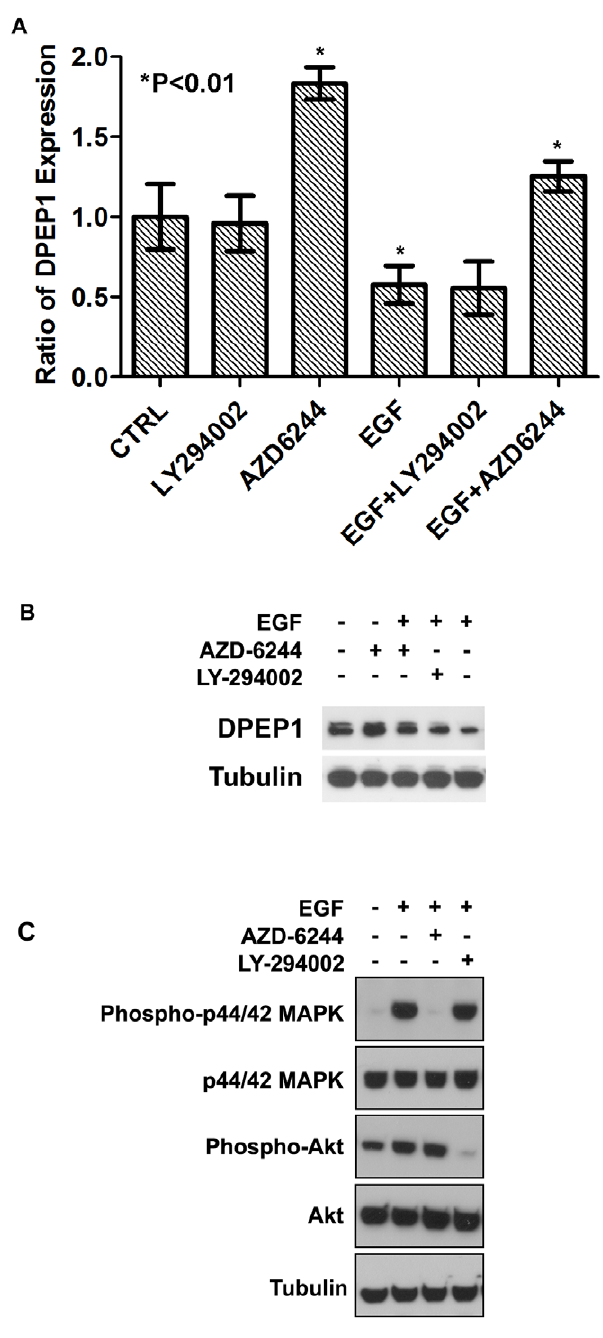
Figure 5. Effect of EGF, AZD6244 and LY294002 on DPEP1 expression. Panc1 cells were starved in 0.1% FBS for 16 hours before treatments. Cells were treated with RPMI medium containing EGF (30 ng/mL), AZD6244 (1.5 m M) or LY294002 (1.5 m M) alone for 24 hours. EGF + AZD6244 or EGF + LY294002: Panc1 ells were pretreated with AZD6244 or LY294002 for 1 h prior to the addition of EGF. Untreated control cells were maintained in RPMI with DMSO. A: Real-time PCR was done to determine DPEP1 mRNA levels. Ratio of DPEP1expression represents the effect of treatment on gene expression compared to untreated control. Data are means 6 S.D. from 3 independent experiments. * T-test P , 0.01. B: Western blot showed similar changes at protein level of DPEP1 after 24 hour treatment. C: Western blot demonstrated the efficiency and specificity of AZD6244 and LY294002.